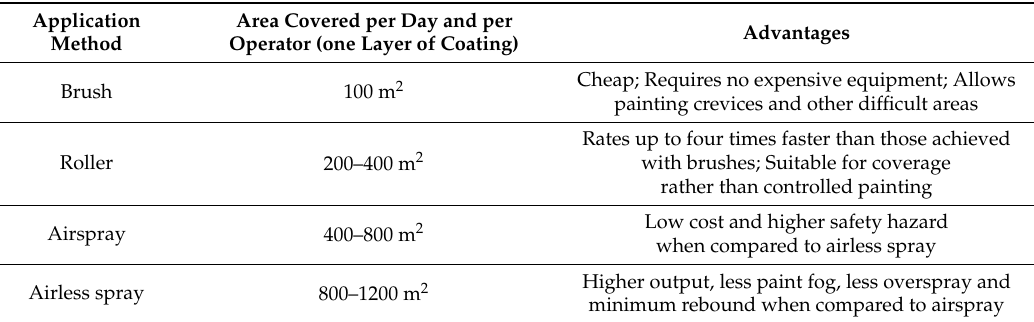
Table 9. Comparison of coating application methods (adapted from [84]).